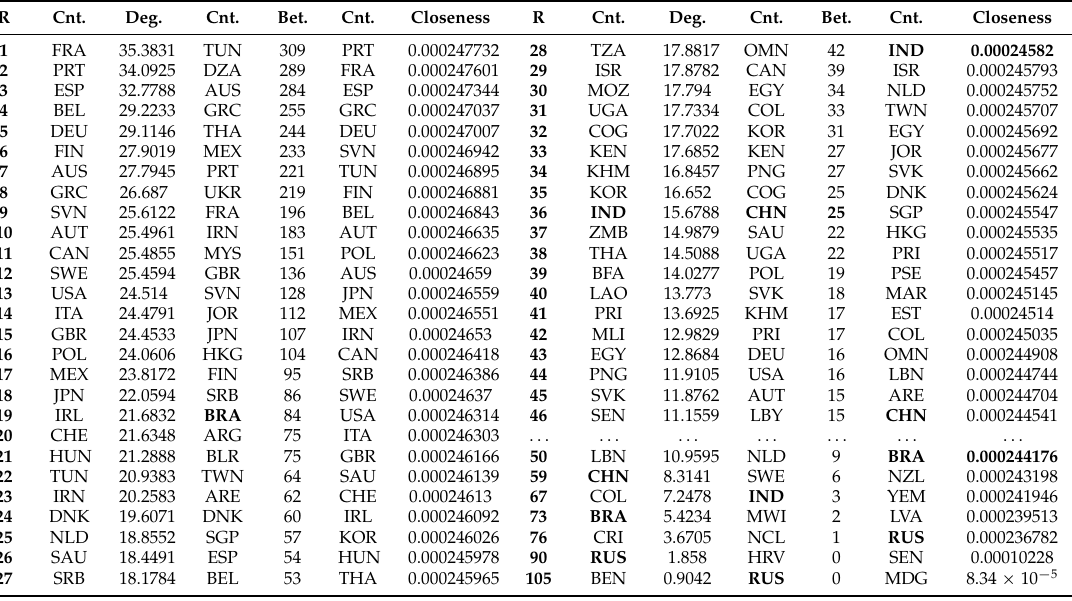
Table 1. Ranking of centrality values for countries. Measures of centrality: Weighted degree (Deg.), betweenness centrality (Bet) and closeness centrality. After position 46 some countries are omitted in order to present all the values for BRIC countries. Total countries in the database: 111. R